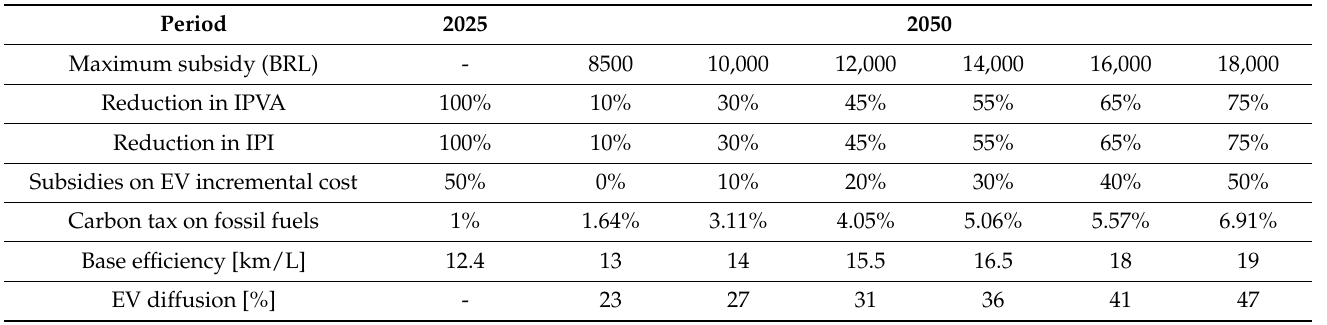
Table 3. Sensitivity analysis of the impact of different rates of EV